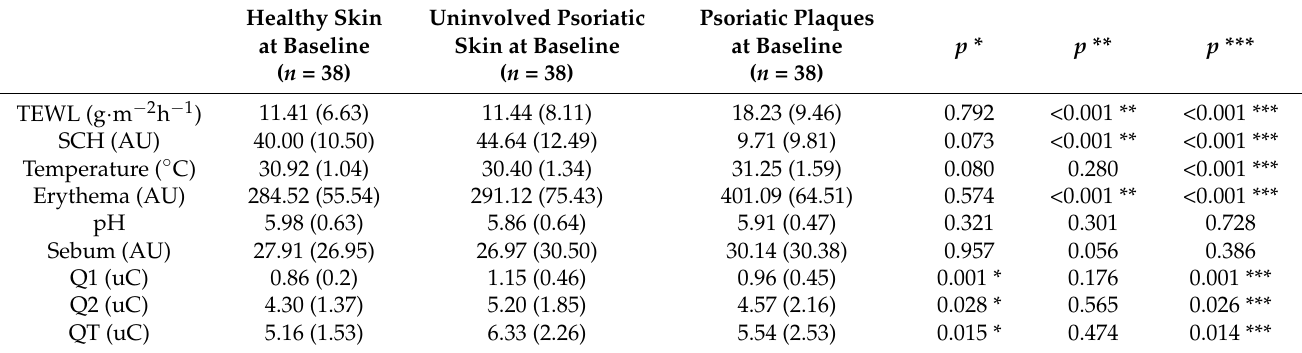
Table 1. Homeostasis parameters in healthy skin, uninvolved psoriatic skin, and involved psoriatic skin at baseline. Healthy